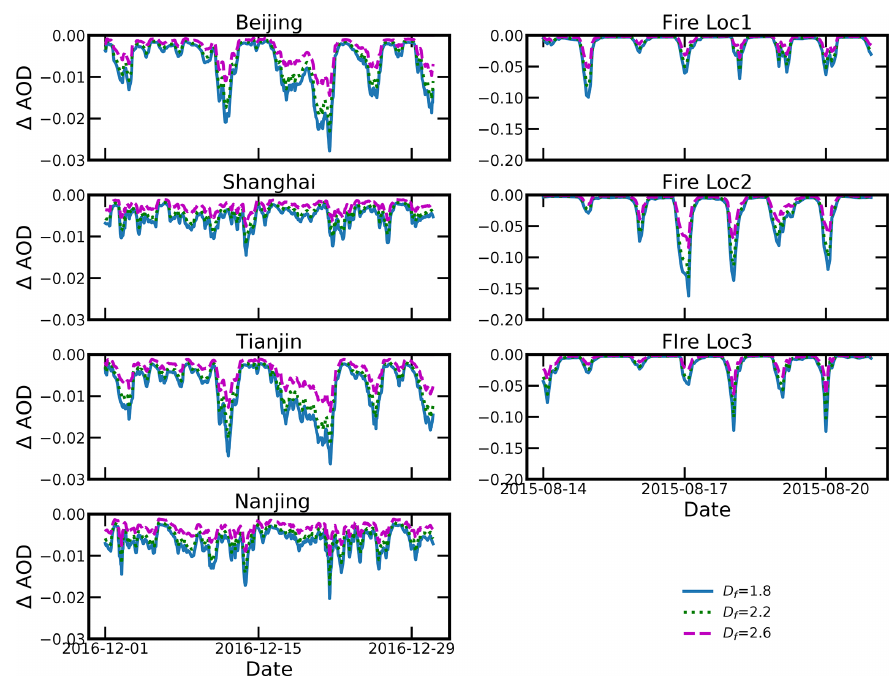
Figure 6. The AOD difference between fractal aggregate models and the spherical model, λ = 550nm.